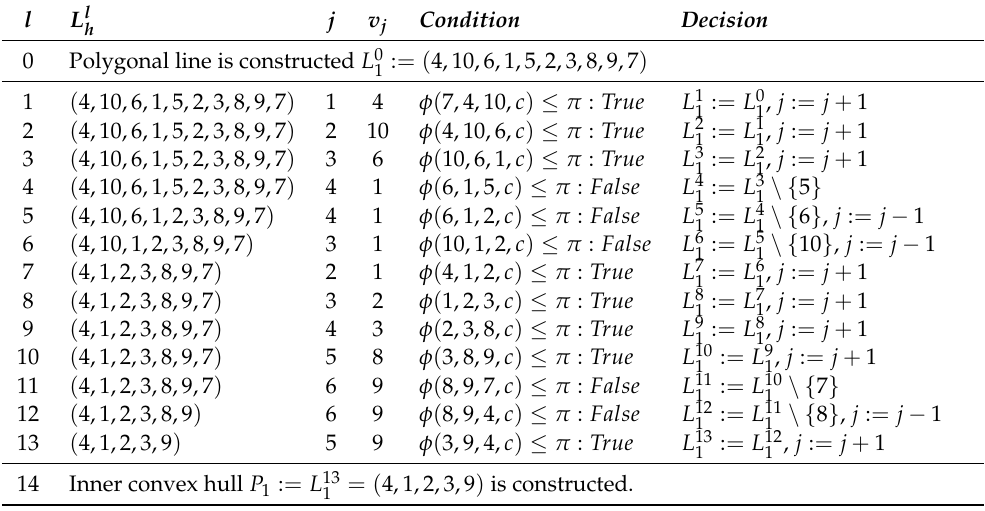
Table 2. Iterations performed by Algorithm 5 ( INNER − CONVEX − HULL ) for the construction of the inner convex polygon P for the example instance “tsp10”.